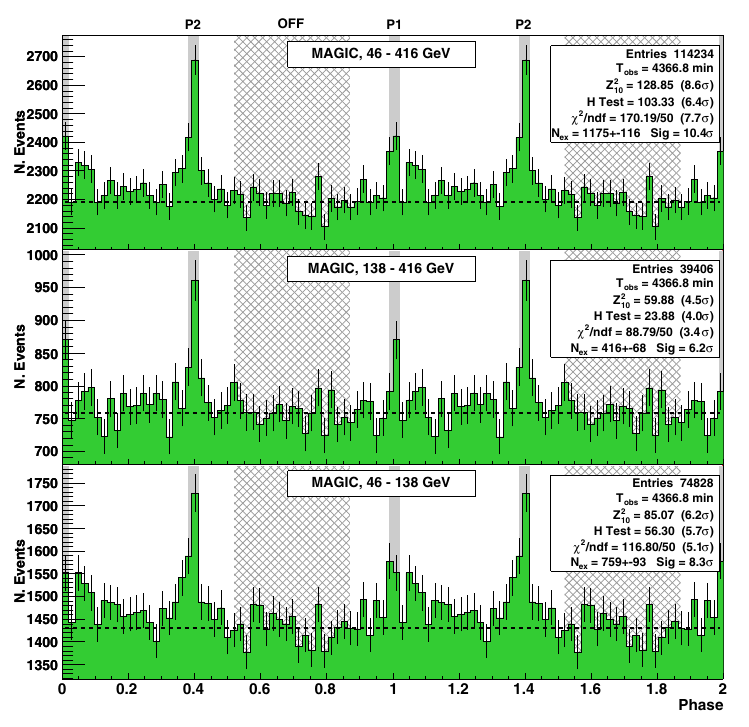
Figure 2. MAGIC folded light curves of the Crab pulsar for our total range in estimated energy and for two separate sub-bins. The shaded areas are the on-phase regions P1 M and P2 M , the light shaded area is the off-region [0.52–0.87]. The dashed line is the constant background level calculated from that